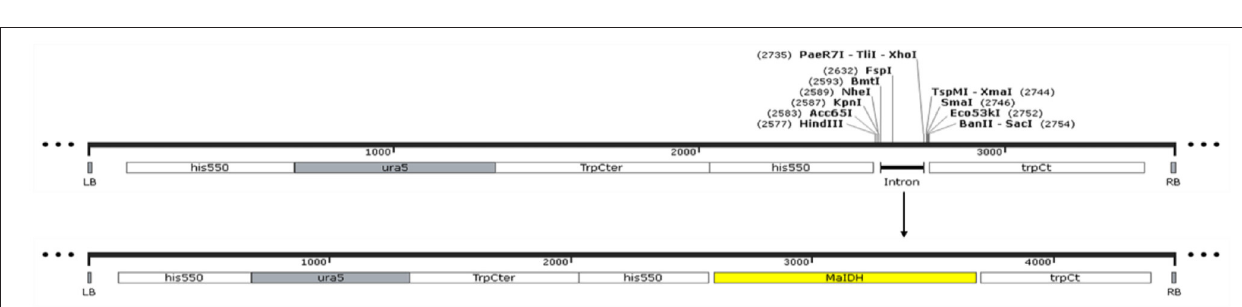
FIGURE 2 | Construction of the vector overexpressing isocitrate dehydrogenases from M. alpina (MaIDHs).